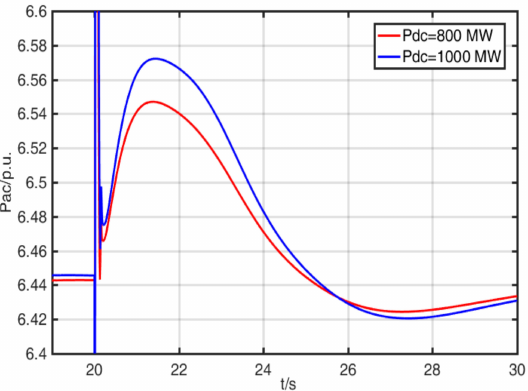
Figure 7. Power oscillations of the AC tie-line at the same stable operating power angle ( δ 120 = 58.6 ◦ ). 4.3. Influence of the Frequency and Damping Ratio of the Dominant Area Oscillation Mode on the Peak Value of